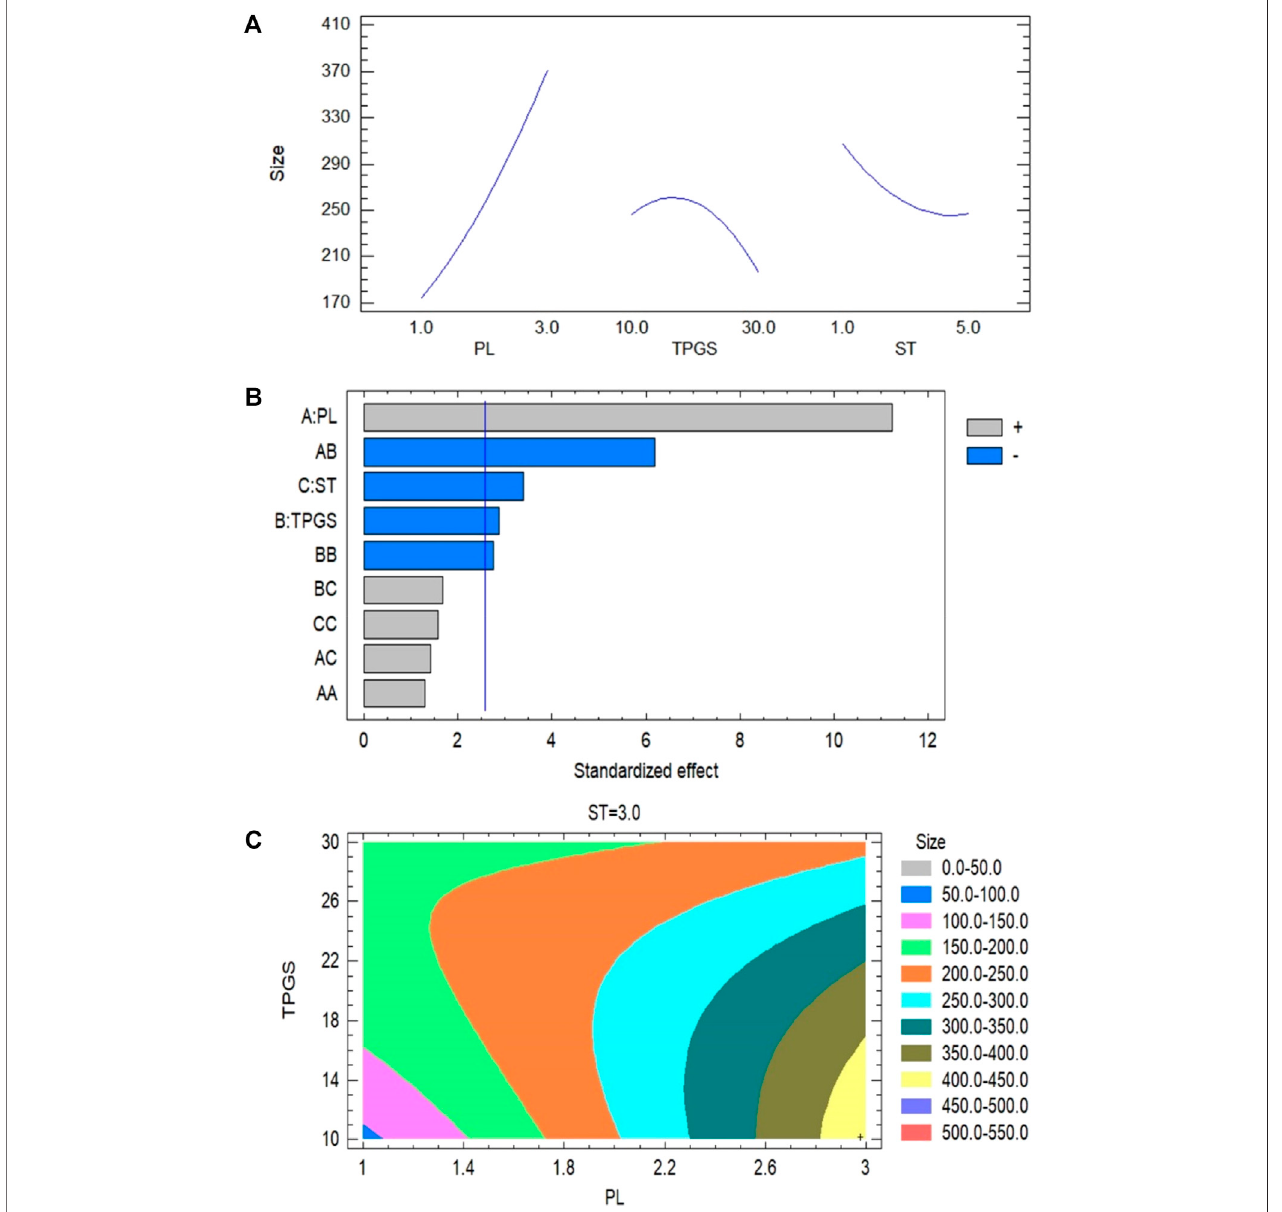
FIGURE 1 | (A) Main plot effect on the interaction of phospholipid, TPGS contents and stirring time on the particle size of 2 ME-loaded micelles formulation. (B) Pareto chart on the interaction of phospholipid, TPGS content and stirring time on the particle size of 2 ME-loaded micelles formulation. (C) Contour plot on the interaction of phospholipid, TPGS content and stirring time on the particle size of 2 ME-loaded micelles formulation.